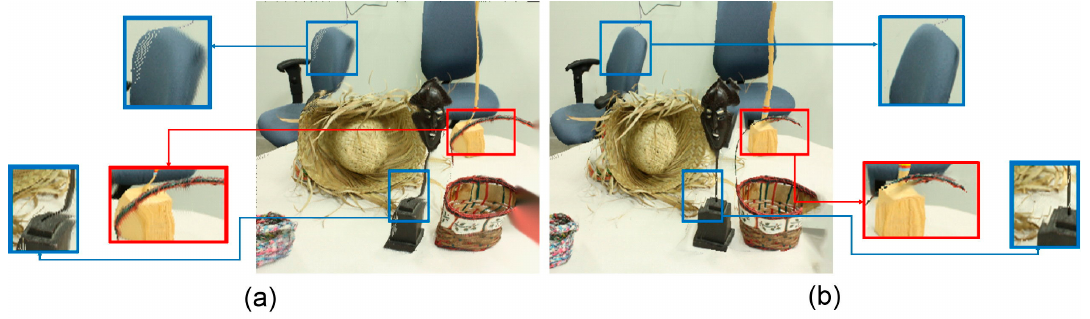
Figure 12. Comparison of the results obtained using ( a ) warping and ( b ) our model.